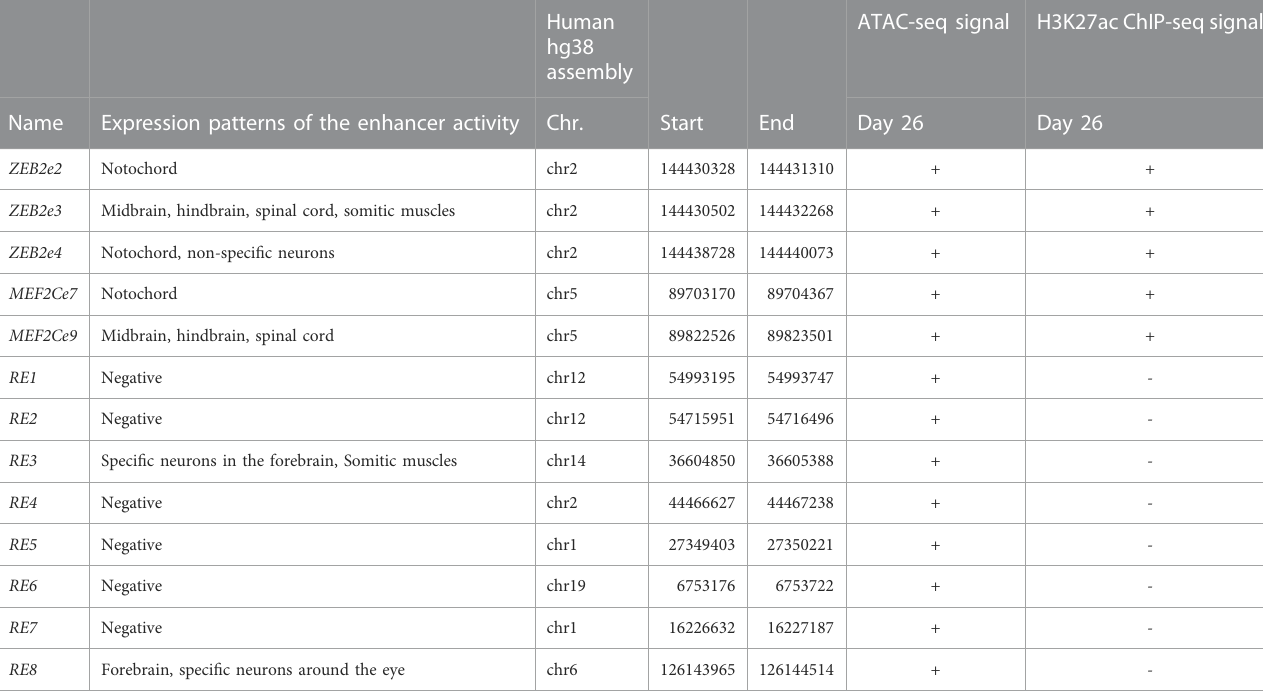
TABLE 1 Enhancer activity of selected putative regulatory elements using zebra fi sh enhancer